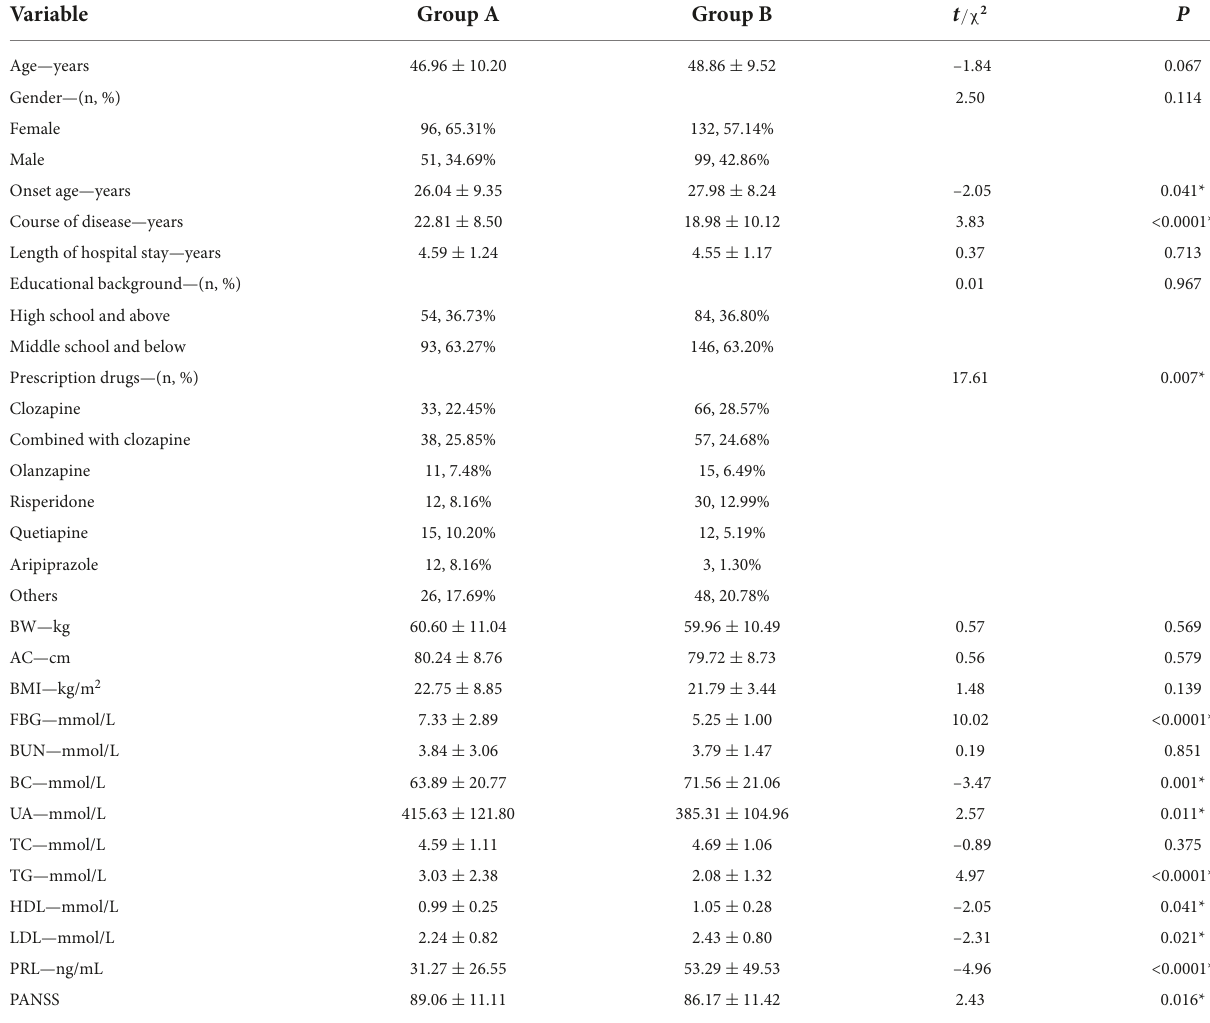
TABLE 2 Differences in general clinical treatment and metabolic parameters between patients with diabetes and without diabetes. Variable Group A Group